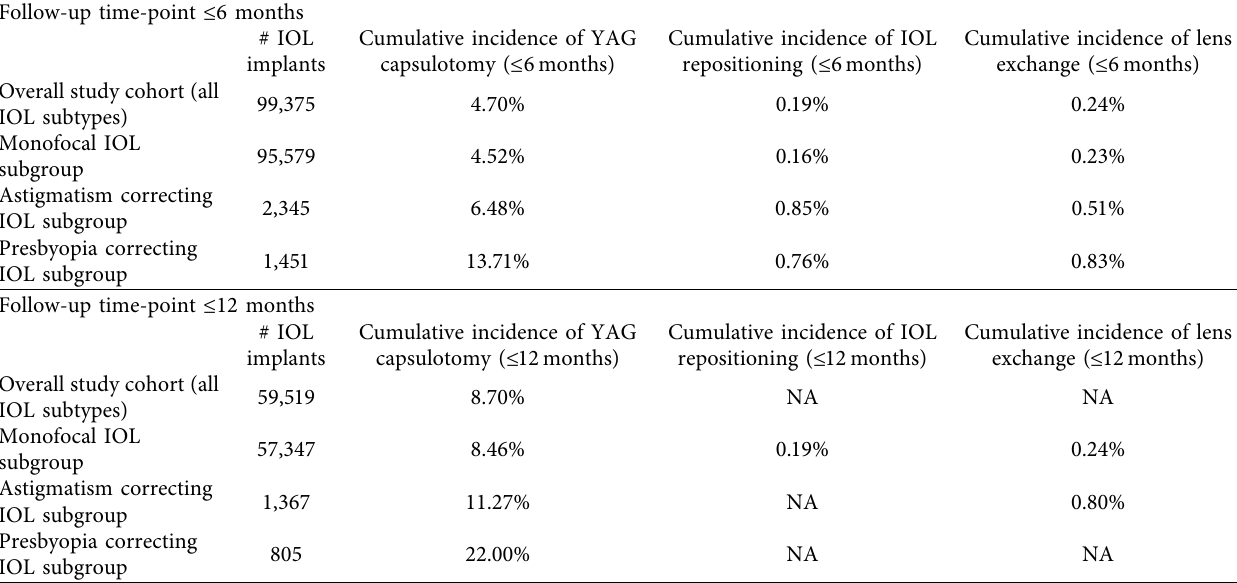
Table 3: Postoperative ocular complications in Medicare fee-for-service patients who have undergone cataract surgery. Complication group Posterior capsular opacification† Retinal tear Retained cataract lens fragments Posterior synechiae of iris Revision or repair of operative wound of anterior segment